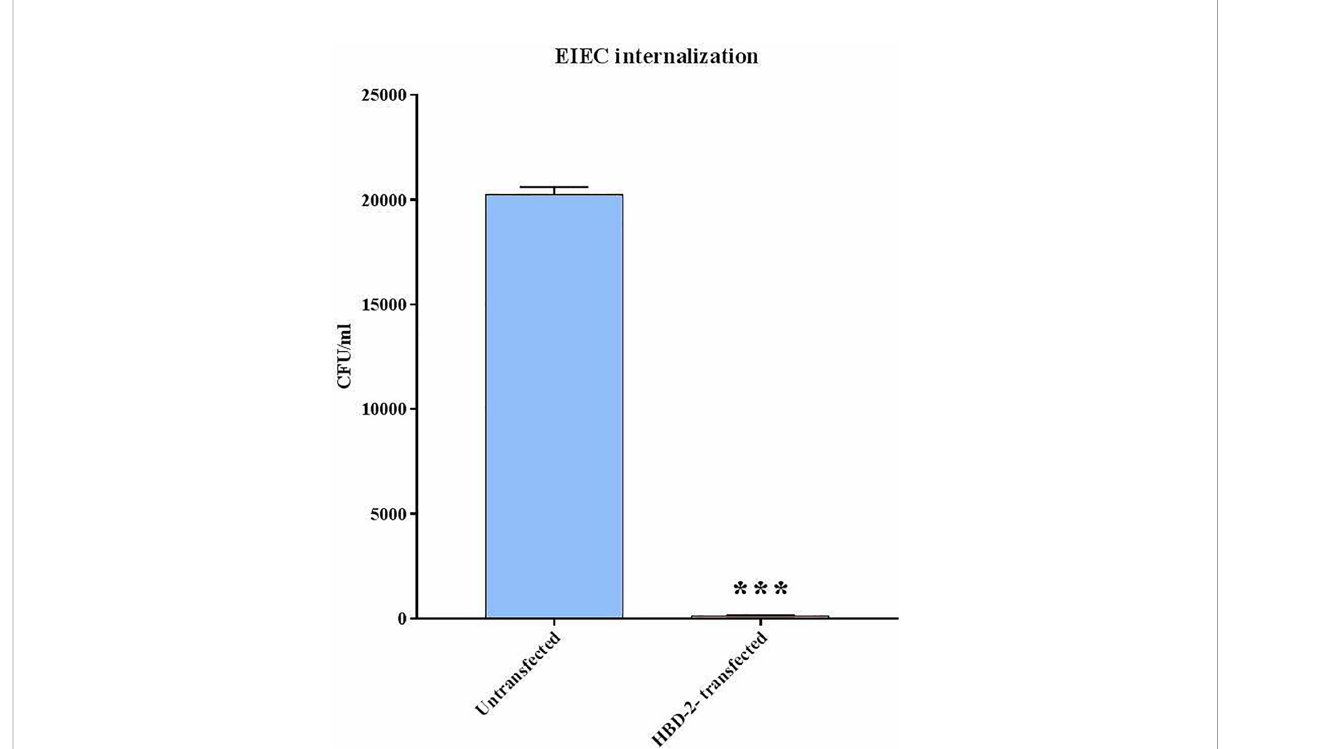
FIGURE 3 EIEC invasion assays. Number of bacteria associated with Caco-2 and Caco-2/HBD-2 cells was determined by host cell lysis, plating, and counting CFUs/ml. Data are representative of three different experiments ± SD. Signi fi cant differences are indicated by